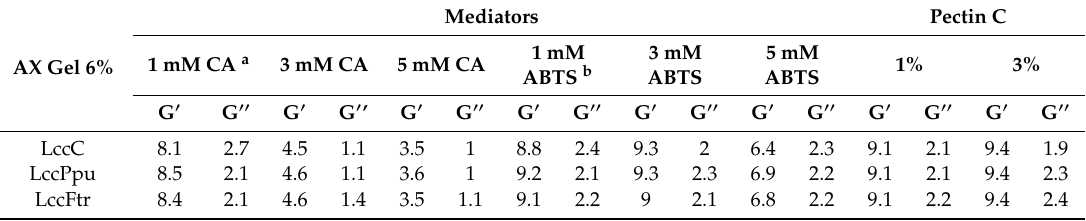
Table 2. Viscoelastic properties of 6% Arabinoxylans (AX) gels, storage modulus G (cid:48) (kPa), and loss modulus G (cid:48)(cid:48) (kPa).